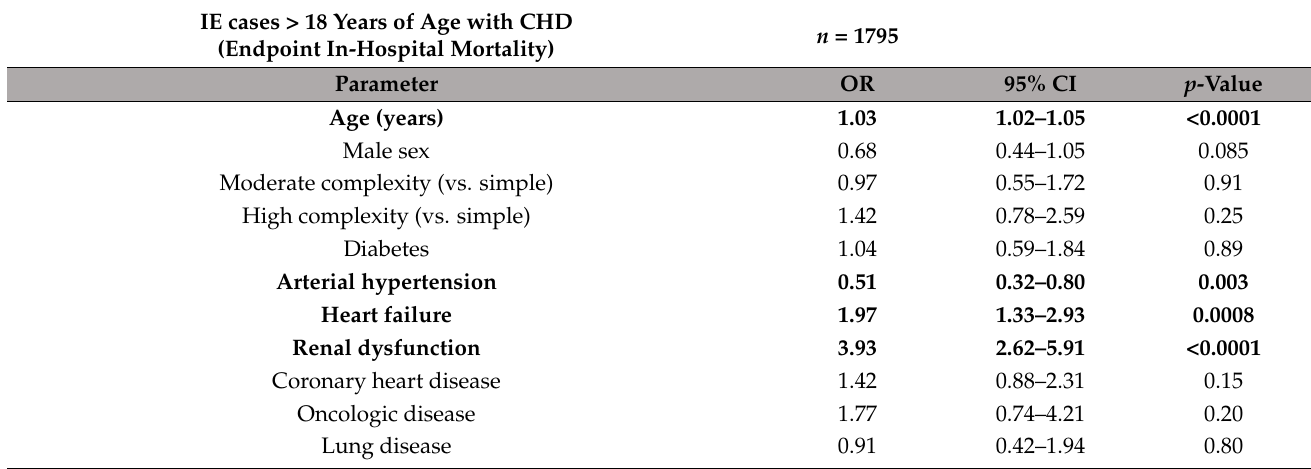
Table 3. Association between age, sex, disease complexity and co-morbidities, and death specifically in adult congen- ital heart disease patients with infective endocarditis. IE = infective endocarditis; CHD = congenital heart disease; CI = confidence interval; OR = odds ratio. Significant variables are in